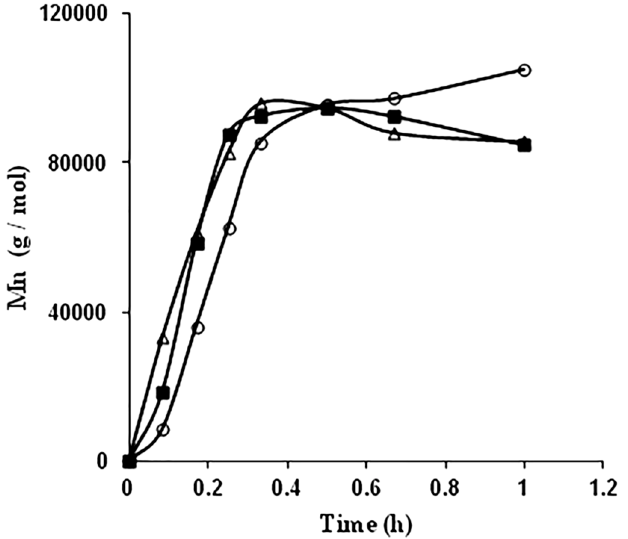
Figure 2. Plot of Mn vs. time at for L-lactide polymerization at different temperatures: o—150 °C; ■ —160 °C; ▲ —180 °C [75].